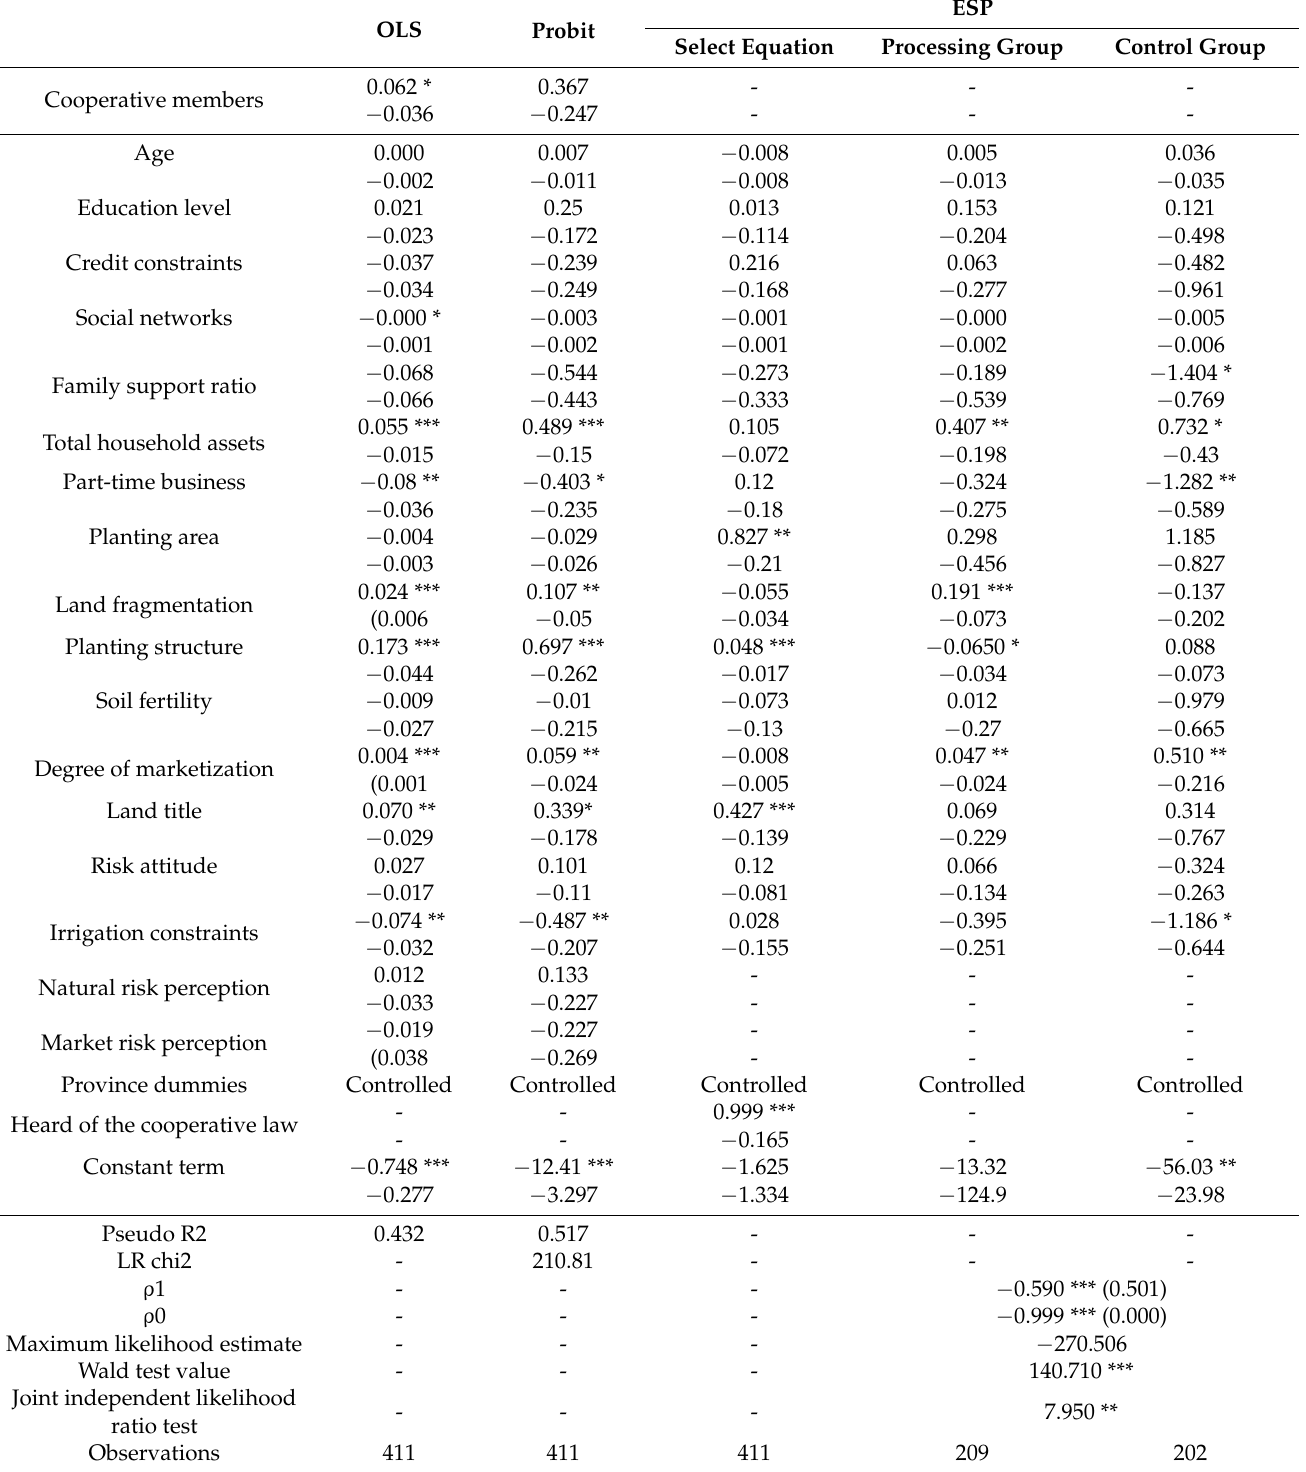
Table 4. OLS, Probit, and ESP estimates of farmers’ adoption of water-saving irrigation technologies vis- à -vis their cooperative